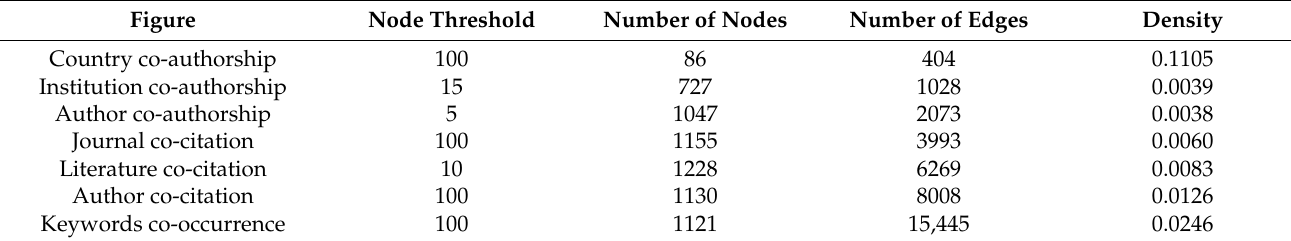
Table 2. Node and Network Characteristics.